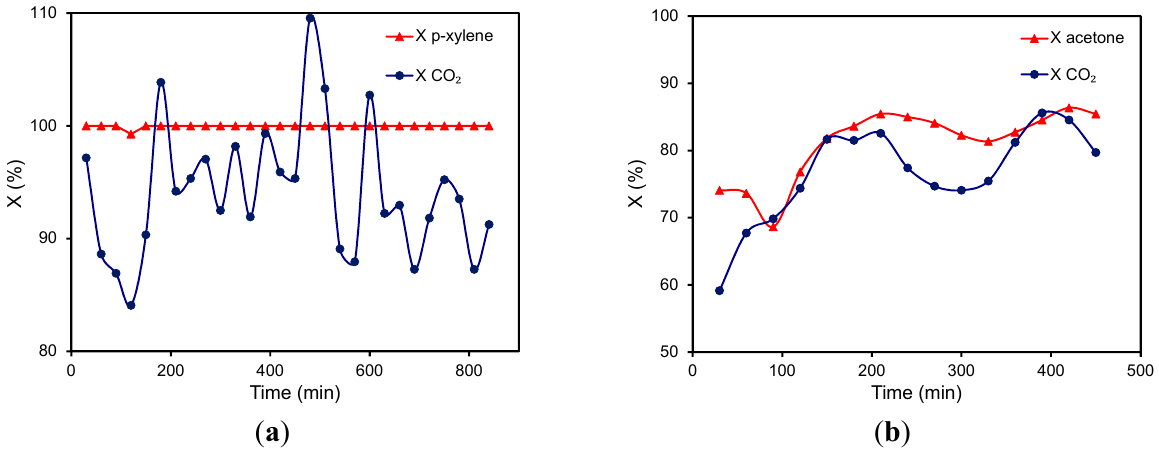
Figure 9. Catalytic stability of A500-Pt over the combustion of ( a ) p -xylene at 170 °C and ( b ) acetone at 210 °C ([VOC] = 1500 ppm, Q = 3.6 L h − 1 , 0.10 g catalyst ). Figures adapted with permission from [64]. Copyright 2011,